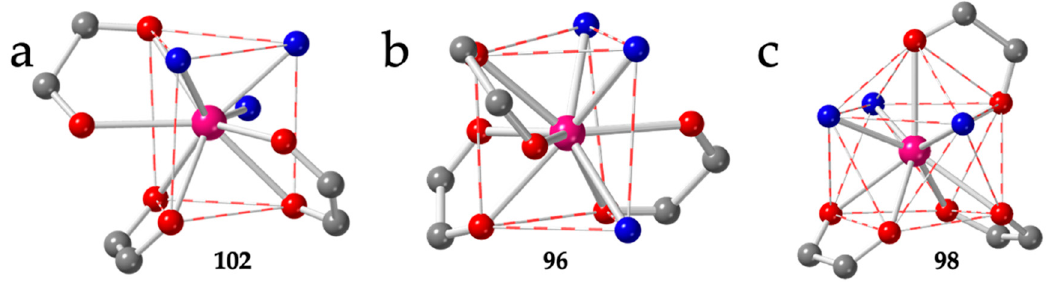
Figure 13. ( a ) View of the coordination environment of the Tm(III) ion in compound 102 . ( b ) View of the coordination environment of the Pr(III) ion in compound 96 . ( c ) View of the coordination environment of the Er(III) ion in compound 98 . Colour code: Ln = pink, C = grey, O anilato = red and O solvent = blue.